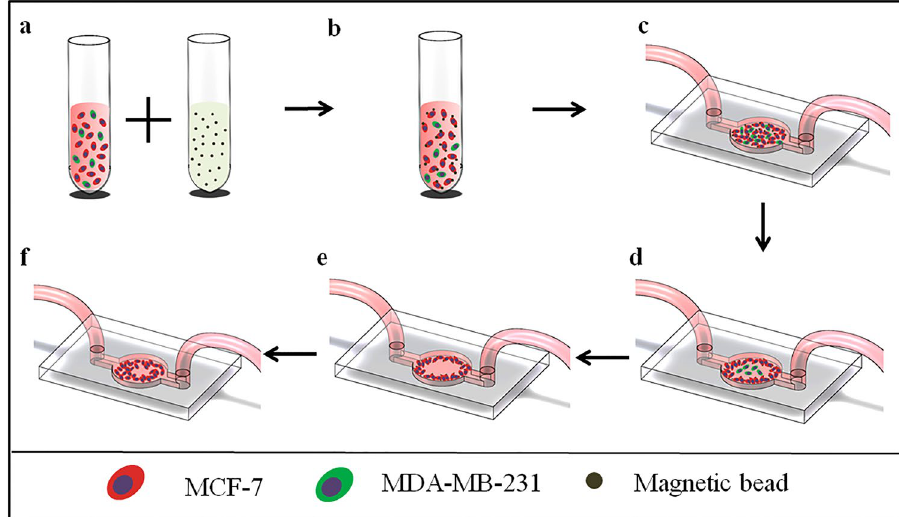
Figure 2. The cell isolation and migration assays. ( a ) MCF-7 and MDA-MB-231 cells were mixed and incubated with anti-EpCAM antibody-modified magnetic beads. ( b ) After incubation for 20 mins, the cell mixture began to bind with the magnetic beads and was then washed with PBS twice. ( c ) The microfluidic chip was pre-treated with fibronectin at a concentration of 50 ng/mL and washed with cell culture medium before the cell mixture was introduced into the channel. The chip was shaken after injecting the cells to ensure the cell suspension was homogeneous. ( d ) MCF-7 cells that bound to the magnetic beads formed a ring-shaped pattern when the chip was placed on the magnet. ( e ) MDA-MB-231-RFP cells were washed away with PBS because they express low EpCAM protein level. This left the MCF-7 cells in a ring-shaped pattern in the channel. ( f ) Then, the cells migrated to the centre of the channel under different